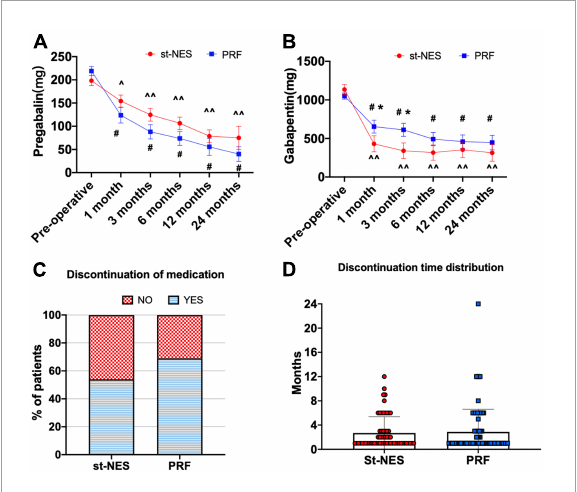
FIGURE6 (A,B) The dosage of pregabalin and gabapentin before and after treatment [ ∧ P < 0.05 and ∧∧ P < 0.0001 indicate pre-operative vs. post-operative dosage in the short-term nerve electrical stimulation (st-NES) group, # P < 0.0001 indicate pre-operative vs. post-operative dosage in the pulsed radiofrequency (PRF) group, * P < 0.05 indicate PRF group vs. st-NES group, P -values for inter- and intra-group comparisons by Mann–Whitney U -test]. (C) Proportion of patients who discontinued medication during the follow-up. (D) Distribution of discontinuation times and number of